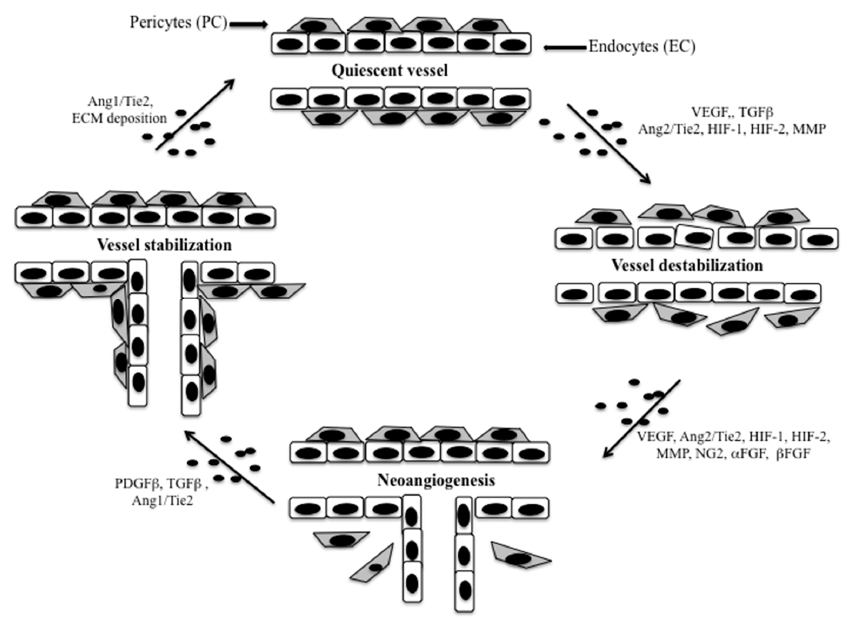
Figure 2. Crosstalk between endothelial cells and pericytes during sprouting angiogenesis: